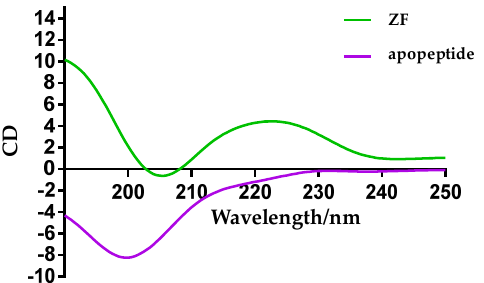
Figure 2. CD spectra of 100 ‐μ M ZF and 100 ‐μ M apopeptide.